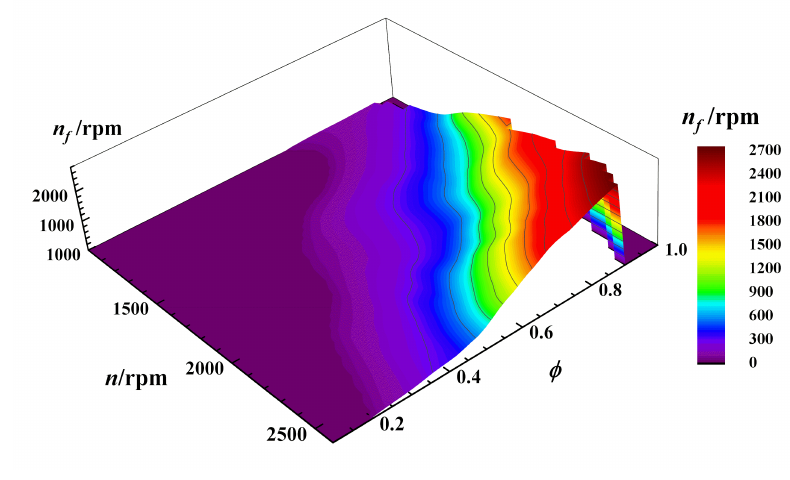
Figure 12. Speed map of fan for T atm = 35 ◦ C.